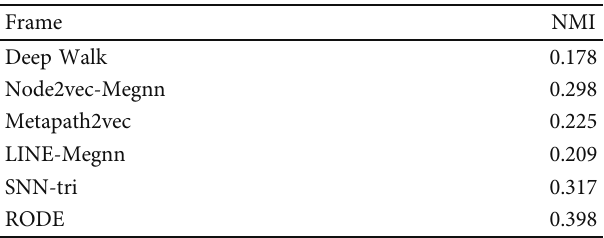
Table 3: Node cluster